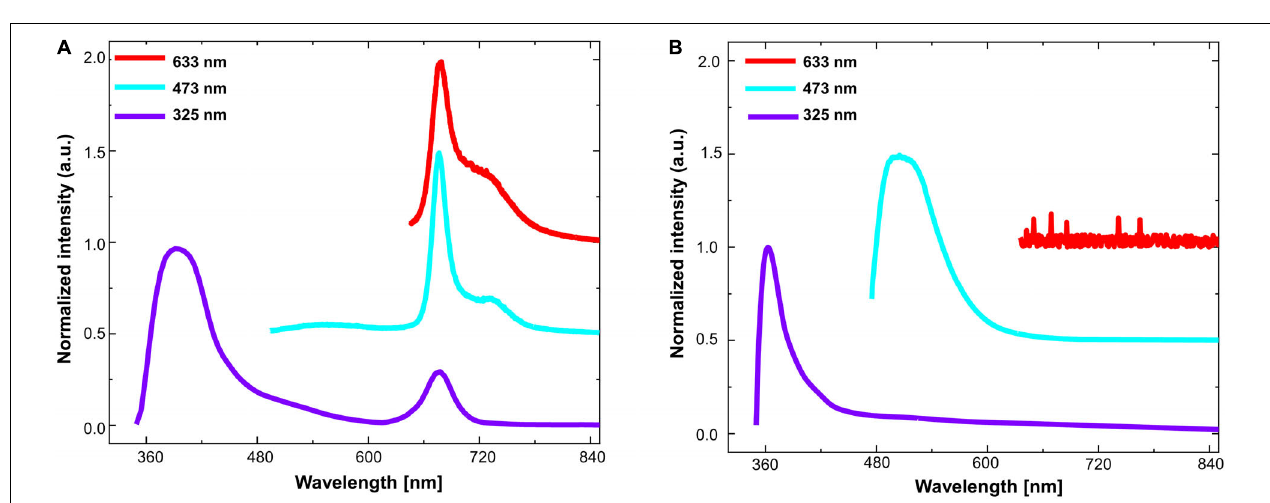
FIGURE 6 | Photoluminescence spectra (at room temperature) under three different laser excitation sources: at 633 nm (red), 473 nm (blue), and 325 nm (violet), respectively for (A) Tridacna maxima mantle tissues and (B) pure guanine